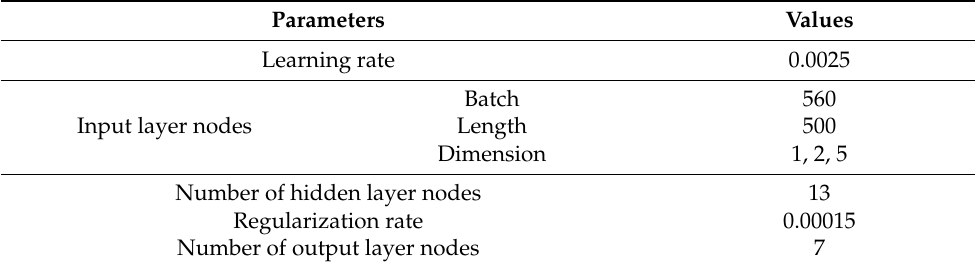
Table 3. LSTM training model parameters and